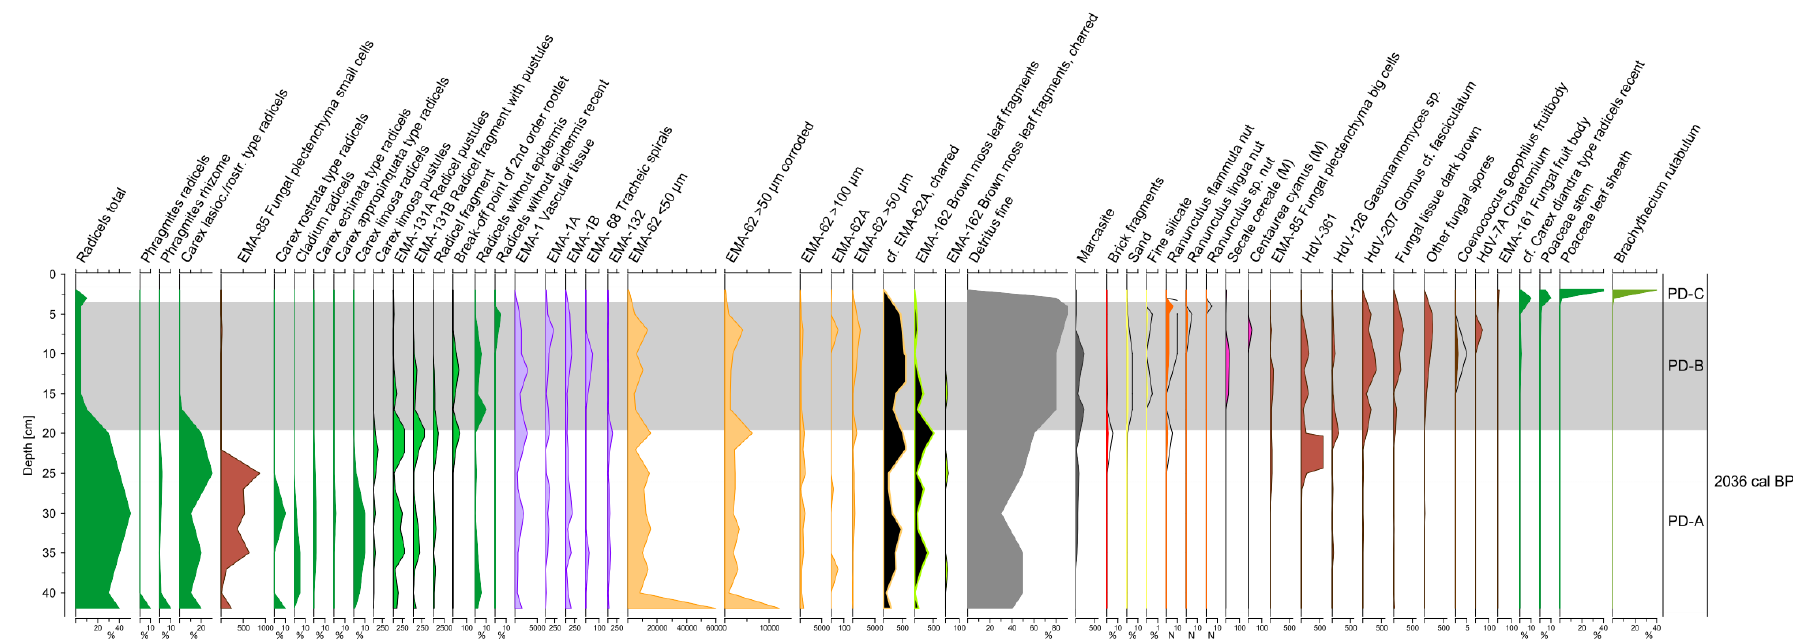
Figure 4. Selected curves of macro- and micro-remain analyses of site Recknitz valley (PD). Note the scales and units of the x-axes. Curves show percentages [%] or number [N] of macro-remains as indicated, or otherwise concentrations [10 1 N cm ‒3 ] of micro-remains.